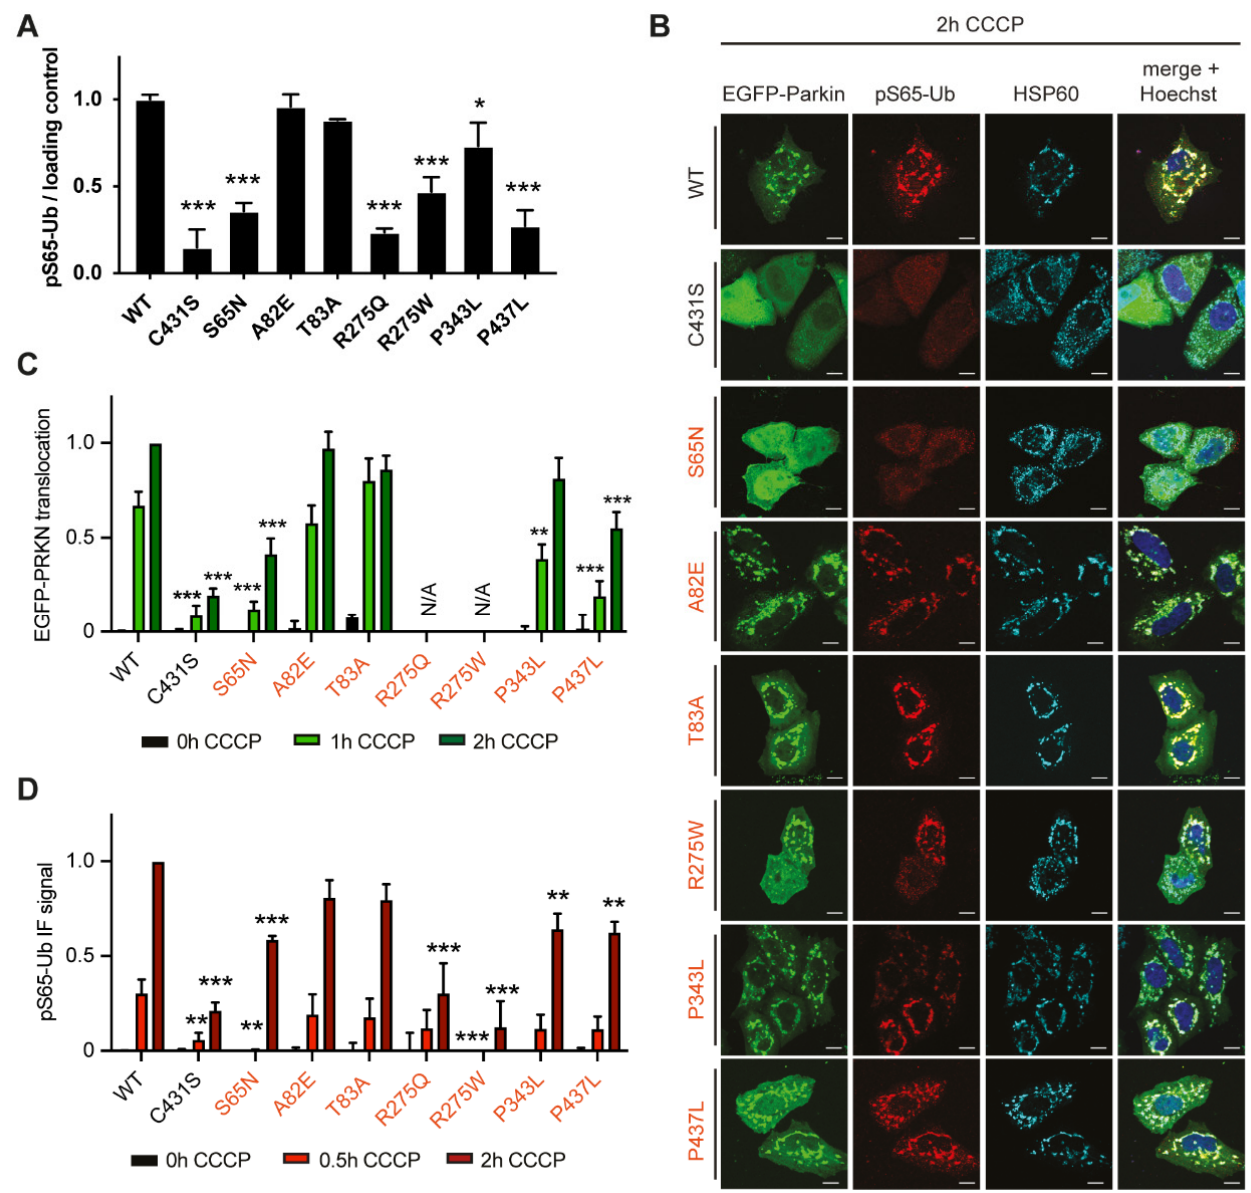
Figure 2. Functional analysis of rare PRKN variants. HeLa cells were transfected with either EGFP- PRKN WT, the catalytically inactive C431S, or rare PRKN variants and treated with CCCP, as indicated. ( A ) Western blots were prepared and immunoblot pS65-Ub levels were quantified and normalized to loading control. Data is shown as the mean ± SEM from at least three independent experiments. Statistical analysis was performed using one-way ANOVA with Dunnett’s multiple comparison test (* p < 0.05, *** p < 0.0005). ( B ) Cells were fixed and stained with antibodies against pS65-Ub (red) and HSP60 (cyan) and nuclei counterstained with Hoechst 33342 (blue). Scale bars correspond to 10 µ m. ( C , D ) Cells prepared as in B were imaged using HCI and analyzed for PRKN translocation ( C ) or pS65-UB signal intensity ( D ). The data of each experiment was normalized between 0 h and 2 h for EGFP-PRKN WT, set to 0 and 1, respectively. Data is shown as the mean ± SEM of at least three independent experiments with four replicate wells per condition. Statistical analysis was performed using two-way ANOVA with Dunnett’s post hoc test to correct for multiple testing (** p < 0.005, *** p < 0.0005).